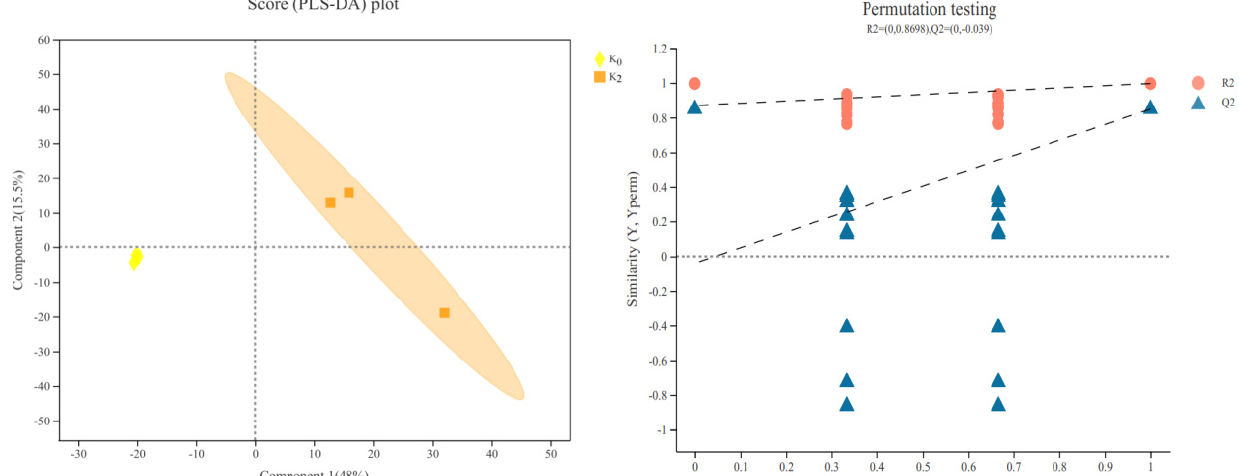
Figure 3. PLS-DA score plot and model validation. K concentrations: K 0 (0 mg · L − 1 ), K 2 (671.4mg · L − 1 ). The greater the degree of separation of the two groups of samples in the figure, the more significant the classification effect. The abscissa represents the permutation retention of the permutation test. The point with a permutation retention of 1 is the R2 and Q2 values of the original model. The ordinate represents the values of the R2 and Q2 permutation tests. The two dashed lines represent the regression lines of R2 and Q2, respectively.